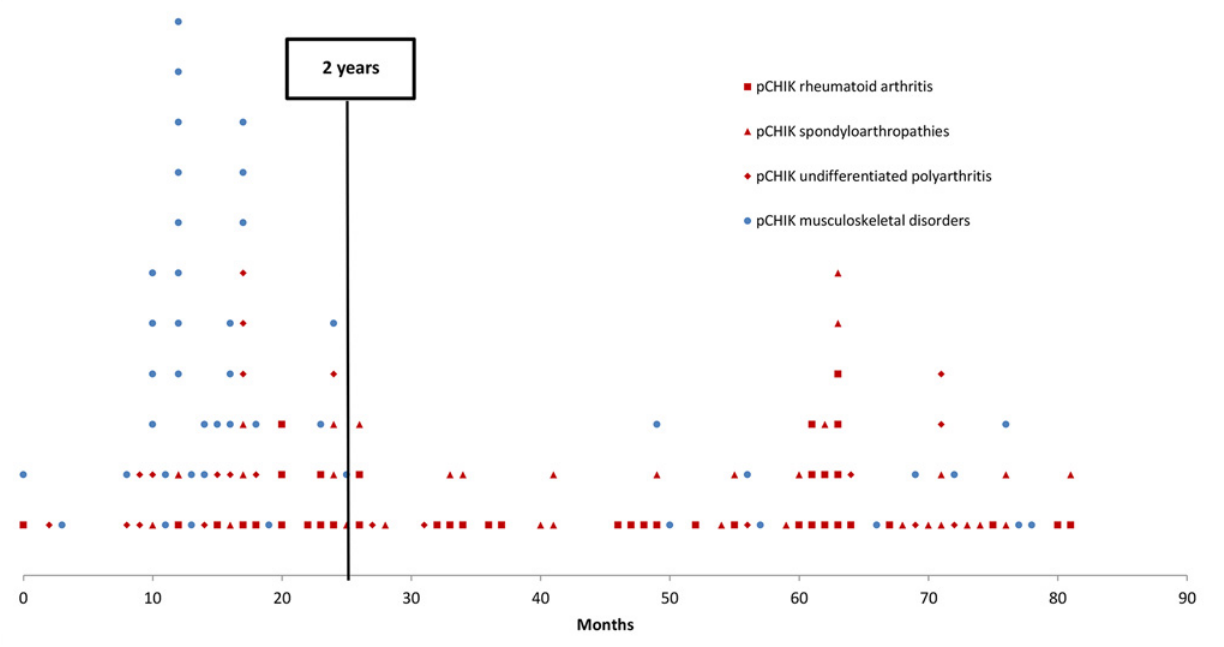
Fig 2. Time elapsed between chikungunya (CHIK) infection and the first visit to a rheumatologist for rheumatic or musculoskeletal disorders, Saint-Denis, Reunion Island, 2006 – 2012: musculoskeletal disorders versus chronic inflammatory rheumatisms.